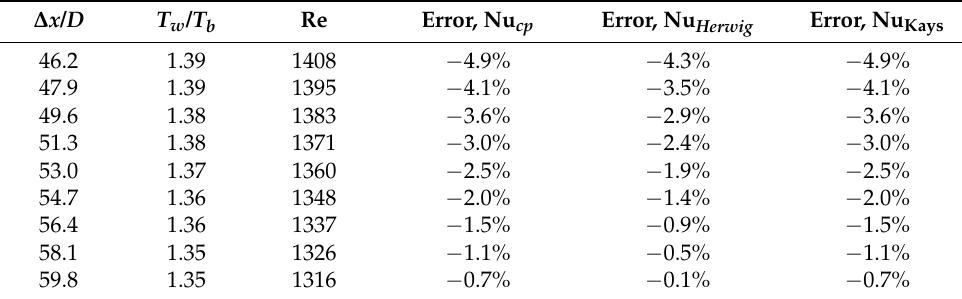
Table 8. Calculation errors of nitrogen by Nu number correlations with case 3.